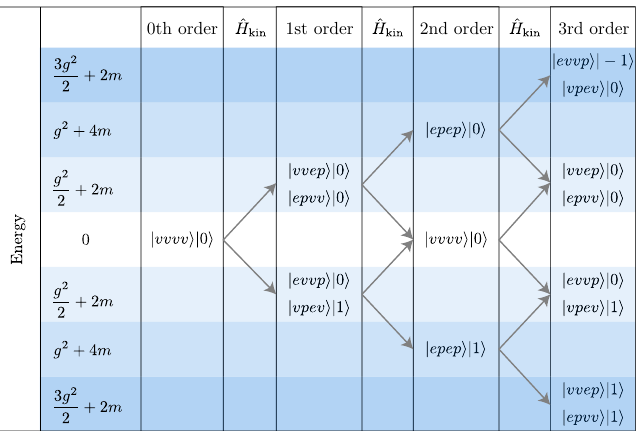
FIG. 12. A schematic description of our perturbative algorithm when starting from the vacuum. In the first column, we show the bare energies of the corresponding states. Each application of the perturbation ˆ H kin allows for creating and annihilating particle-antiparticle pairs, as depicted by the tree structure. At each iteration, our algorithm expands the Hilbert space to include new terms contributing to the correction. This allows for efficient use of the resources, ultimately reaching several hundred orders in perturbation